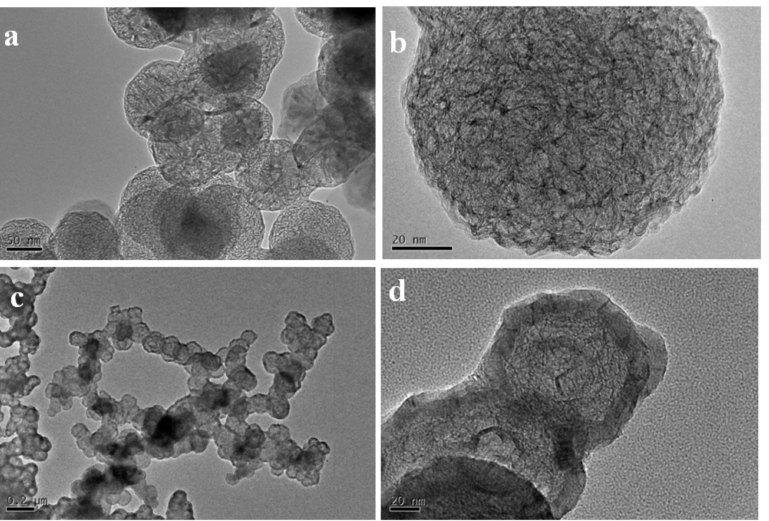
Figure 6. Typical TEM images of the 3DGNs obtained from SiC − C@graphene nanostructures of: ( a , b ) S5 and ( c , d )